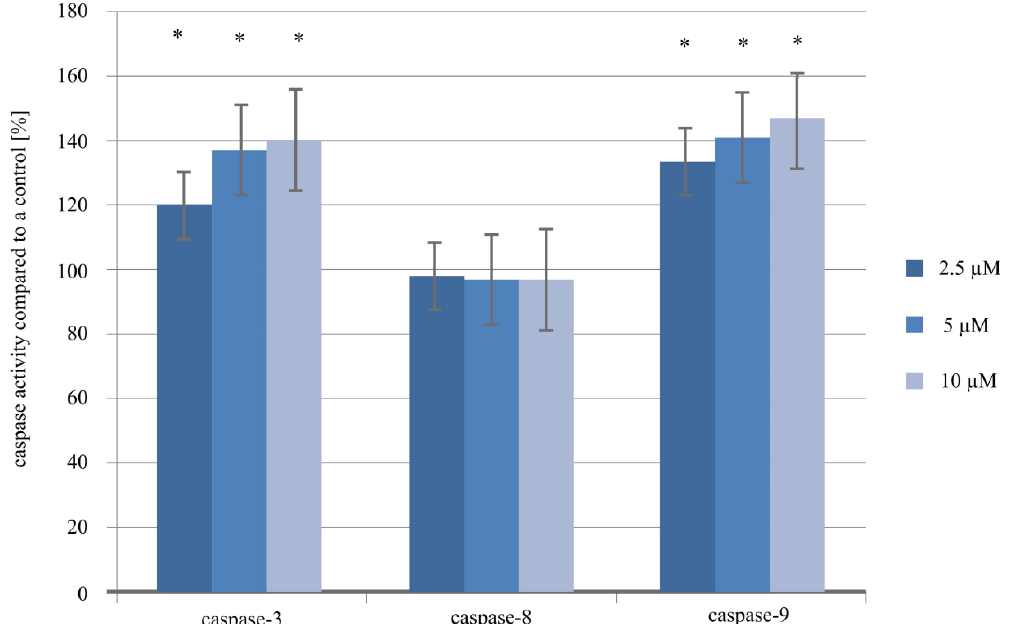
Figure 3. Caspase-3, -8 and -9 activity in the Ishikawa cell line exposed to 2.5 µM, 5 µM and 10 µM cisplatin for 24 h (*—statistically significant differences in comparison to the control cell culture; p < 0.05; control: cells treated with PBS;